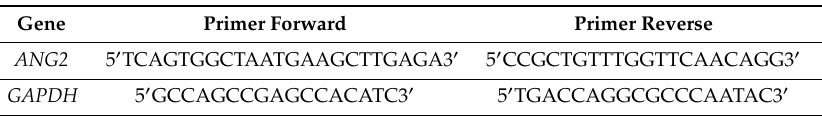
Table 3. List of PCR primers.